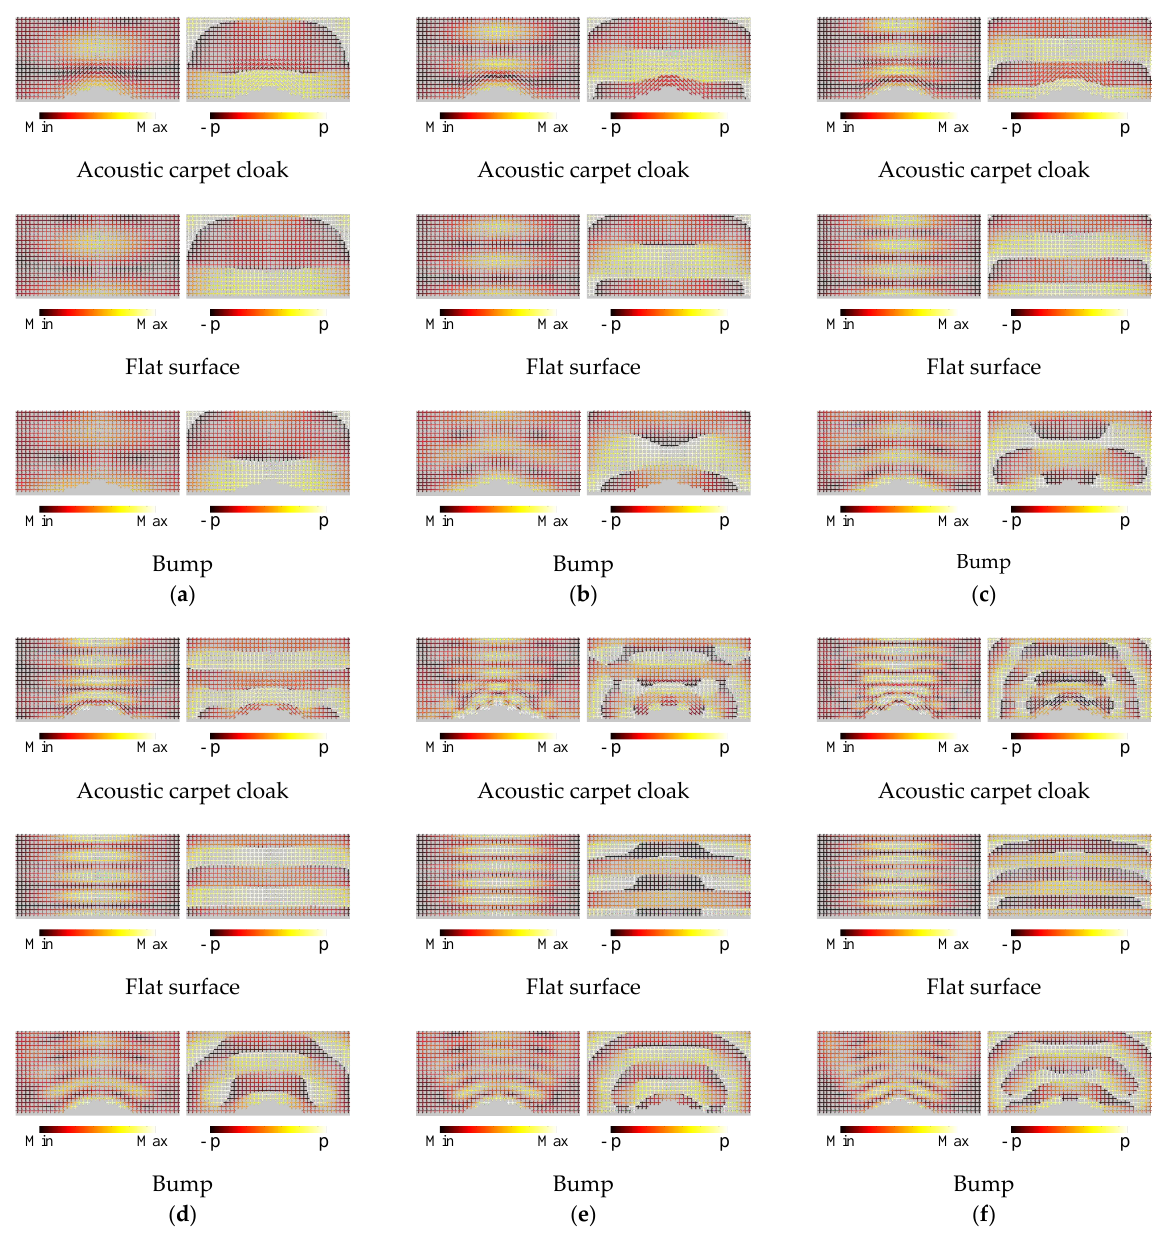
Figure 13. Complex sound pressure distributions for the acoustic carpet cloak, the flat surface, and the bump. ( a ) 1.0 kHz ( λ / ∆ d = 22.3); ( b ) 1.5 kHz ( λ / ∆ d = 14.8); ( c ) 2.0 kHz ( λ / ∆ d = 11.1); ( d ) 2.5 kHz ( λ / ∆ d = 8.91); ( e ) 3.0 kHz ( λ / ∆ d = 7.42); ( f ) 3.5 kHz ( λ / ∆ d = 6.36). Left: Amplitude. Right: